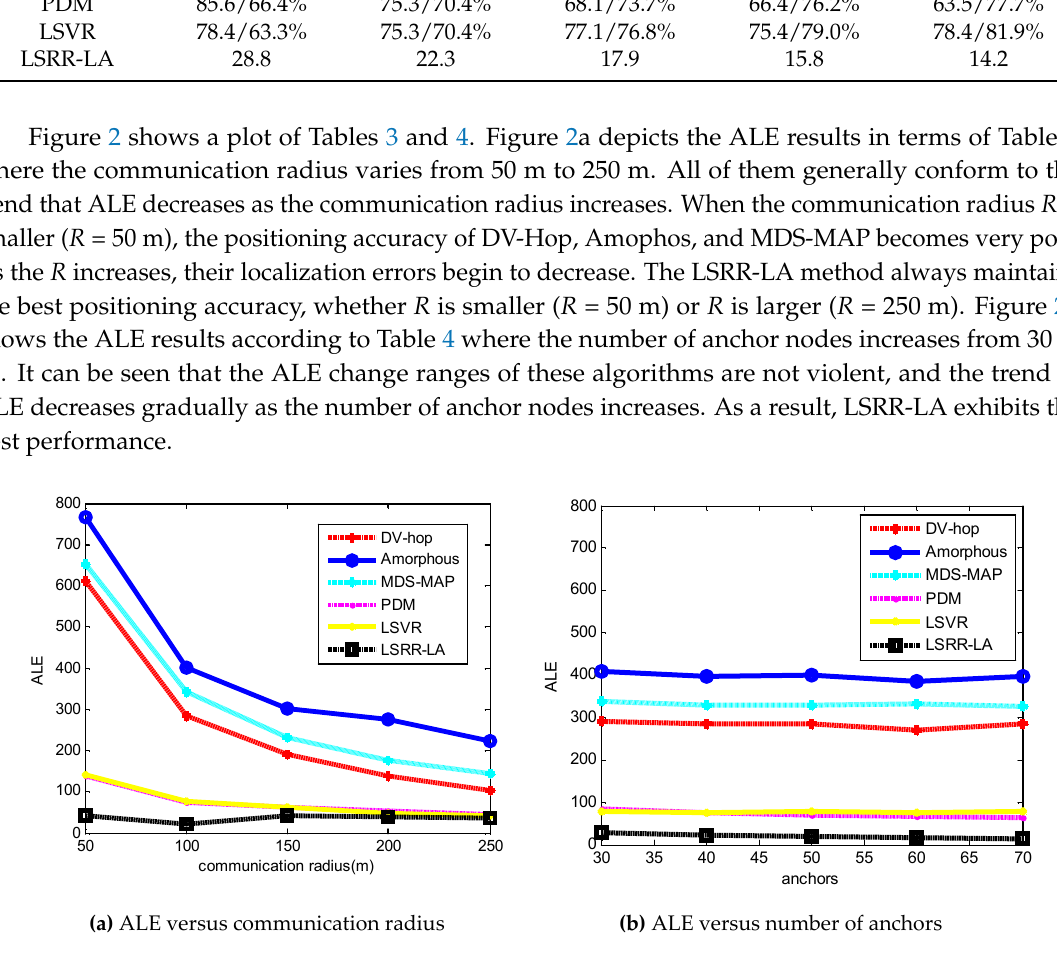
Figure 2. The ALE results of C-shaped regular networks.